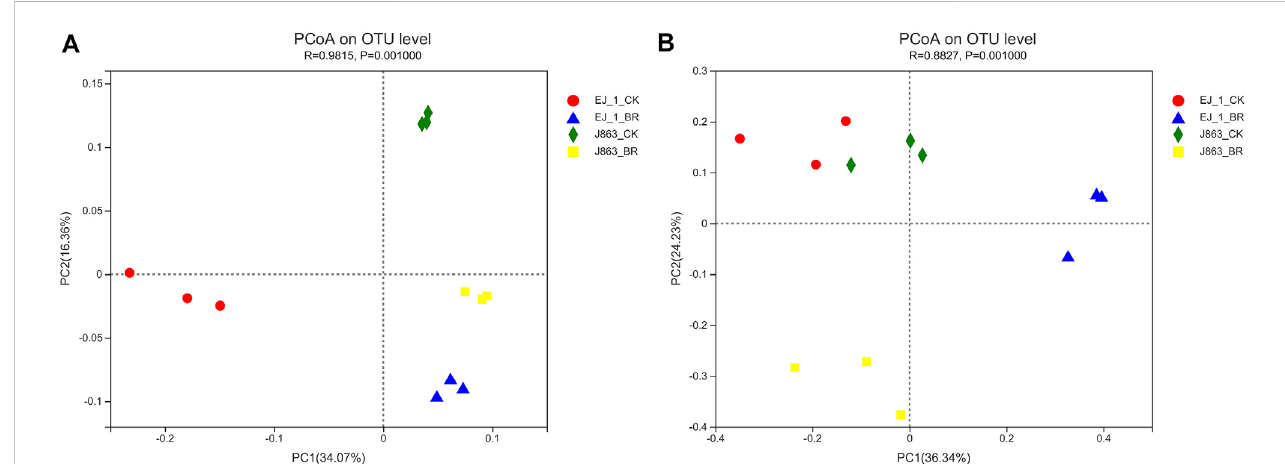
FIGURE 4 Principal component analysis (PCA) of microbial communities at the OTU level under different treatments. (A) bacterial, (B) fungal. CK represents treatment with blank control, BR represents treatment with broccoli residues. EJ-1 represents susceptible cultivar for CVW, J863 represents resistant cultivar for CVW.